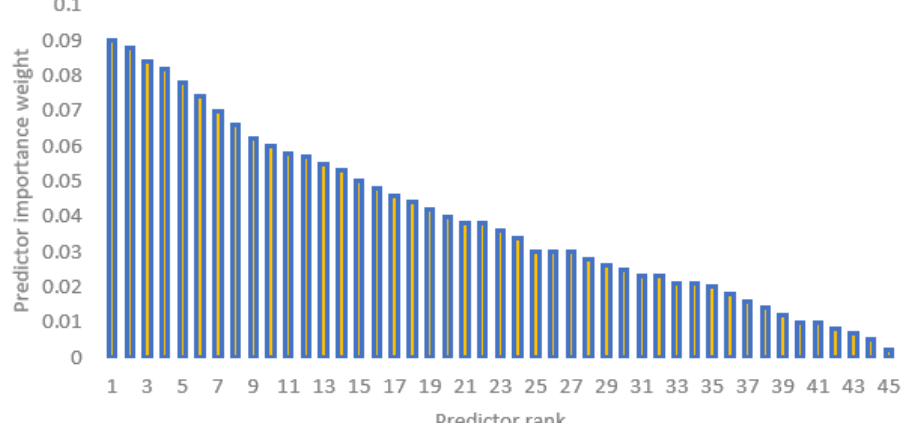
Figure 3. Weight ranking of features.